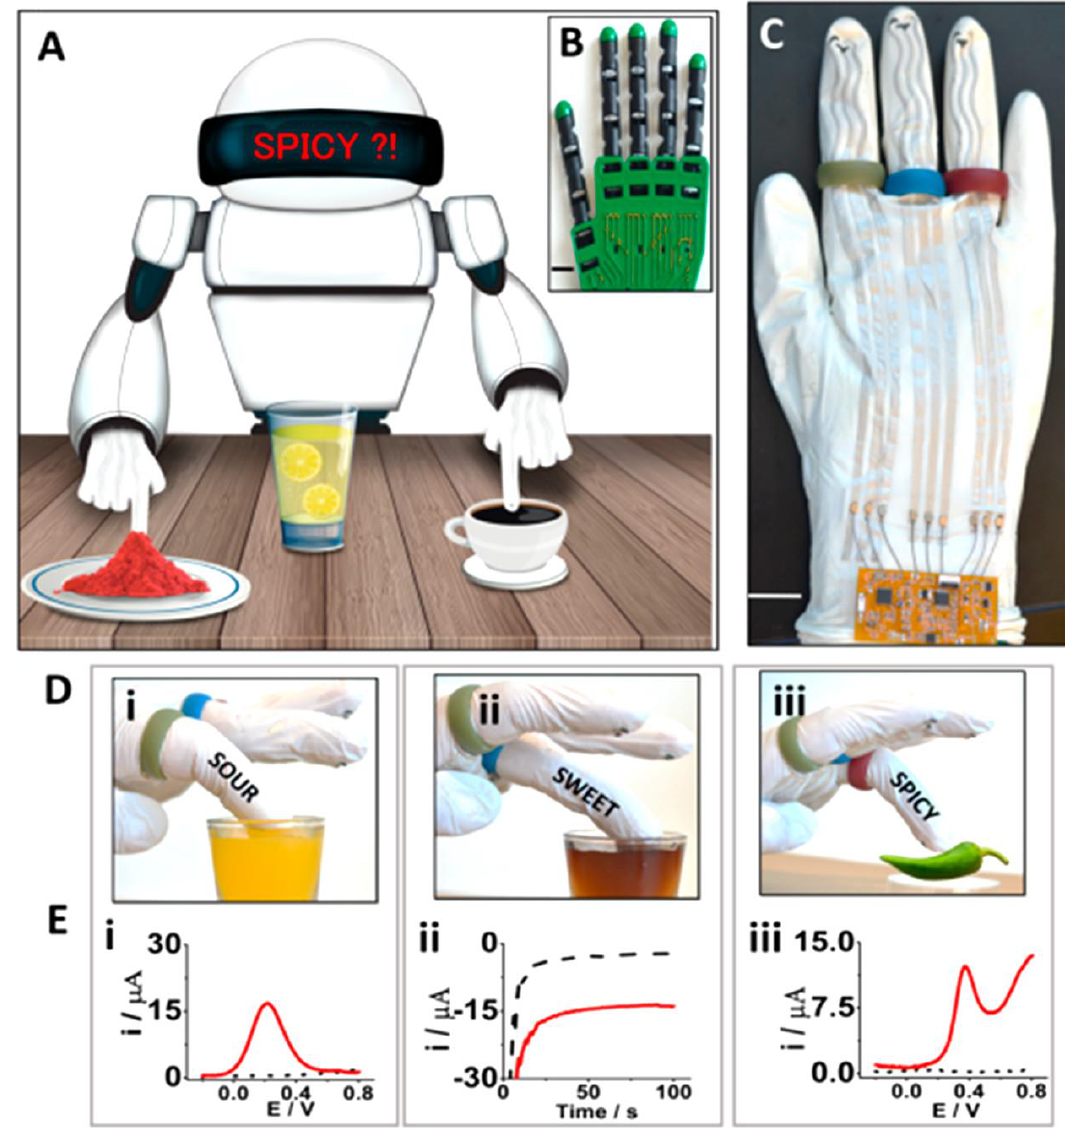
Figure 7. Robotic Sense fingers: schematics, fabrication, and analytical performance. ( A ) Schematics of robotic fingers immersed in lemon juice, coffee, and chili powder placed on the table for subsequent detection of sourness, caffeine, and spiciness, respectively. ( B ) Image illustrating the robotic hand used to develop the glove-based sense fingers. ( C ) Prototype of the screen-printed robotic sense fingers with long connections to the wrist where the electronic interface is located. Robotic fingers are identified with colored rings: green for carbon-printed sour-finger, blue for GOx Prussian blue carbon-printed sweet-finger, and red for carbon-printed spicy-finger. Scale bar, 5 cm. ( D ) Images and ( E ) corresponding electrochemical data of ( i ) robotic sour-finger dipped in orange juice and the SWV signature of ascorbic acid, ( ii ) robotic sweet-finger in cherry juice and amperometry data of glucose, and ( iii ) spicy-finger on green-pepper and SWV feedback response to the presence of capsaicin. Dotted lines correspond to the blank PBS response. Reprinted with permission from Ciui, B.; Martin, A.; Mishra, R.K.; Nakagawa, T.; Dawkins, T.J.; Lyu, M.; Cristea, C.; Sandulescu, R.; Wang, J. Chemical Sensing at the Robot Fingertips: Toward Automated Taste Discrimination in Food Samples. ACS Sens. 2018 , 3 , 2375–2384. https://doi.org/10.1021/acssensors.8b00778. Copyright {2022} American Chemical Society